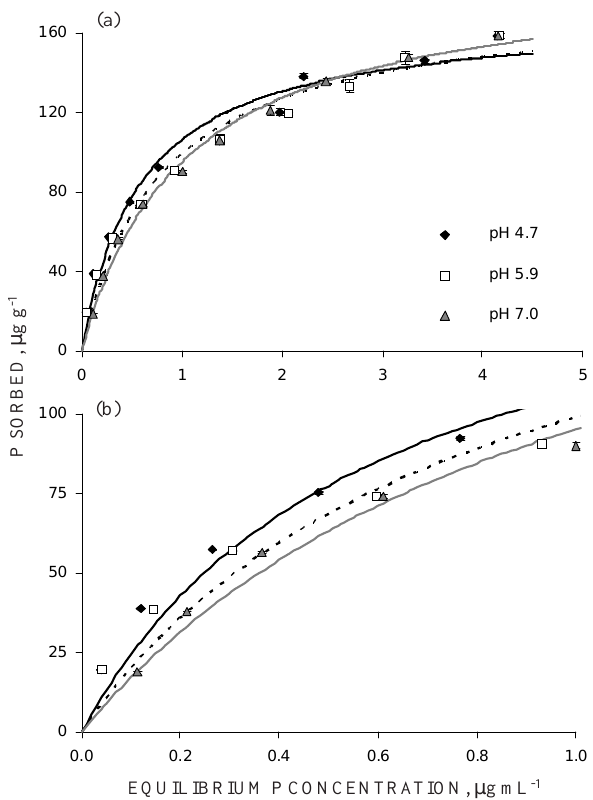
Figure 1. Phosphorus sorption isotherms at three different soil pH levels with equilibrium concentration of (a) 0–5 µg mL -1 of P and (b) 0.0–1.0 µg mL -1 of P.